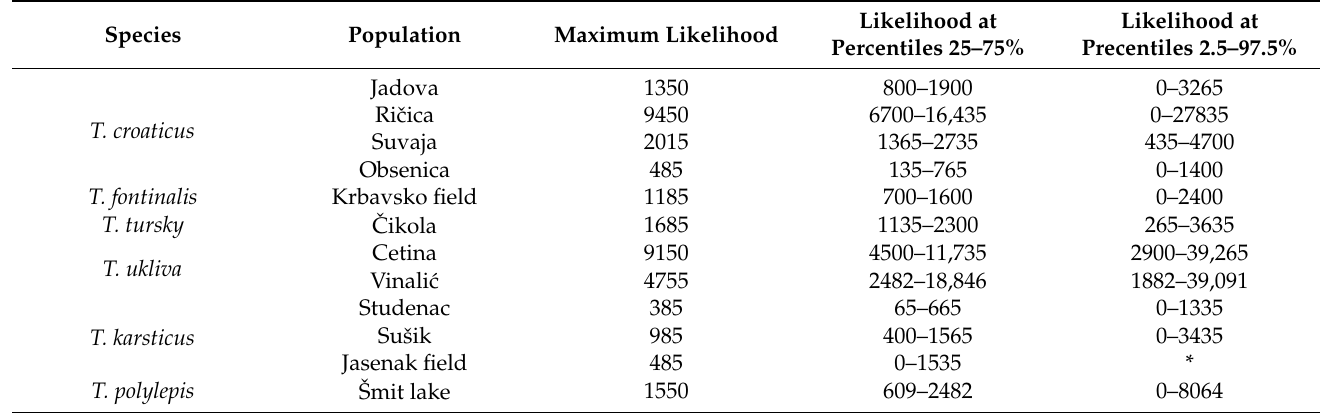
Table 3. Effective population sizes of the endemic Telestes species. *—convergence at certain per- centiles could not be